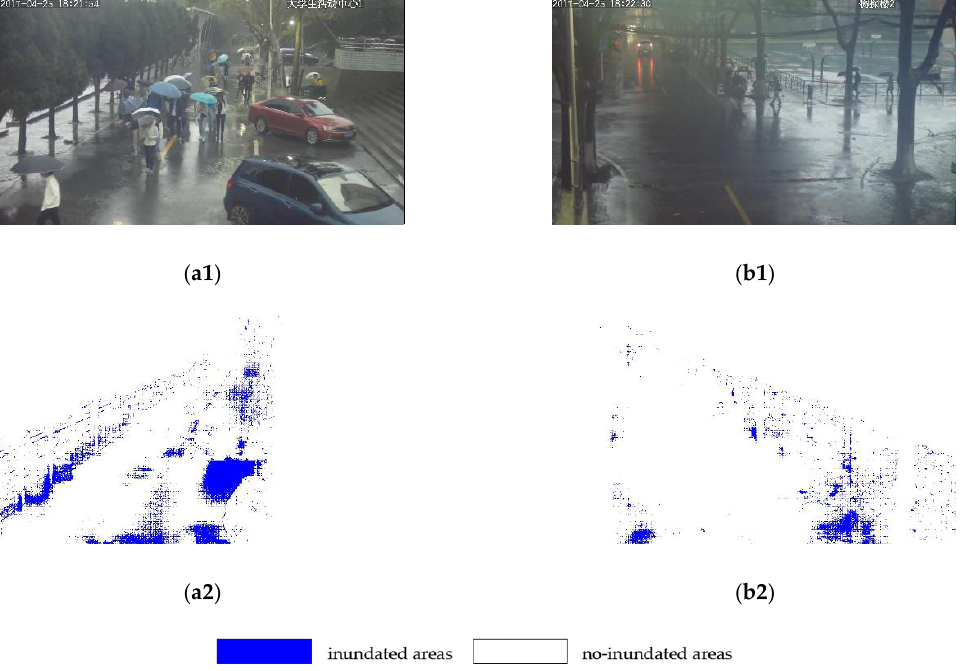
Figure 10. Inundated areas extraction: Origin images ( a1 , b1 ) and Results of inundated area extraction ( a2 , b2 ).